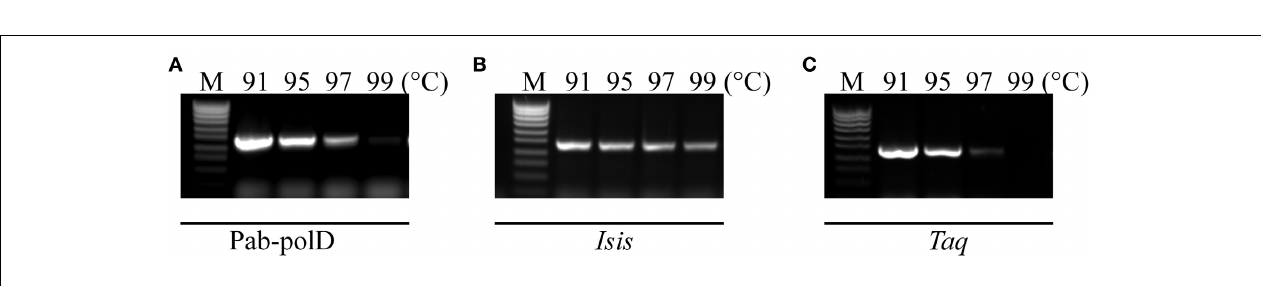
FIGURE 3 | Impact of thermal denaturation during cycling. PCR amplification of the 0.5kb target ( Table 1 ) was carried out with 0.1 U of Pab-polD (A) , 1 U of Pab-polB (B) , and 1 U of Taq-polA (C) in their respective